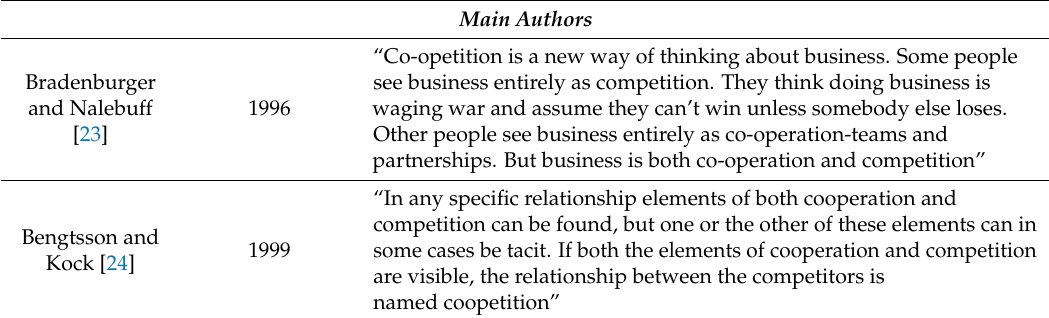
Table 3. Main contributions on the definitions of